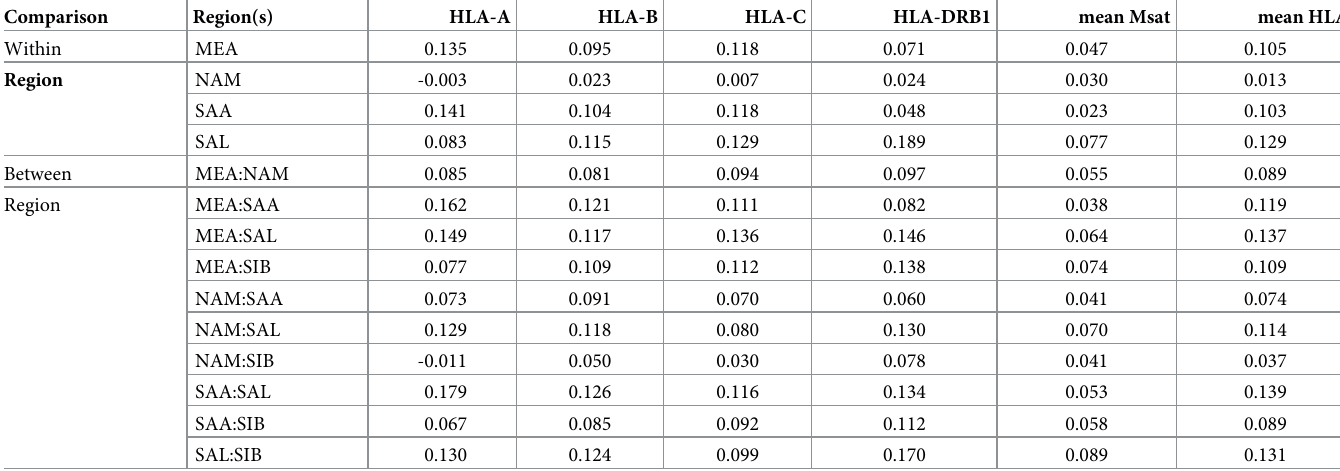
Differentiation based on F . We quantified genetic differentiation among populations ST and regions by computing F for both HLA and microsatellites. We first averaged all pairwise ST values within or between populations, to obtain estimates of mean pairwise F for differ- F ST ST ent geographic scales (Table 8). Nearly all pairs of regions have high levels of differentiation, particularly for contrasts involving SAL and NAM. The only case in which regions showed low differentiation was for the contrast between the single SIB population and the NAM popula- tions. This result once again shows the pattern of secondary migratory flow between these regions. The F values at HLA loci are consistently higher than those for microsatellites (Fig 6), a ST result which remains unchanged when the R measure is used for the microsatellites, and ST despite the fact that our method controls for differences in heterozygosity values at these two sets of markers (see methods). The higher differentiation at HLA loci differs from the expecta- tion under balancing selection, which is that of decreased differentiation relative to neutral